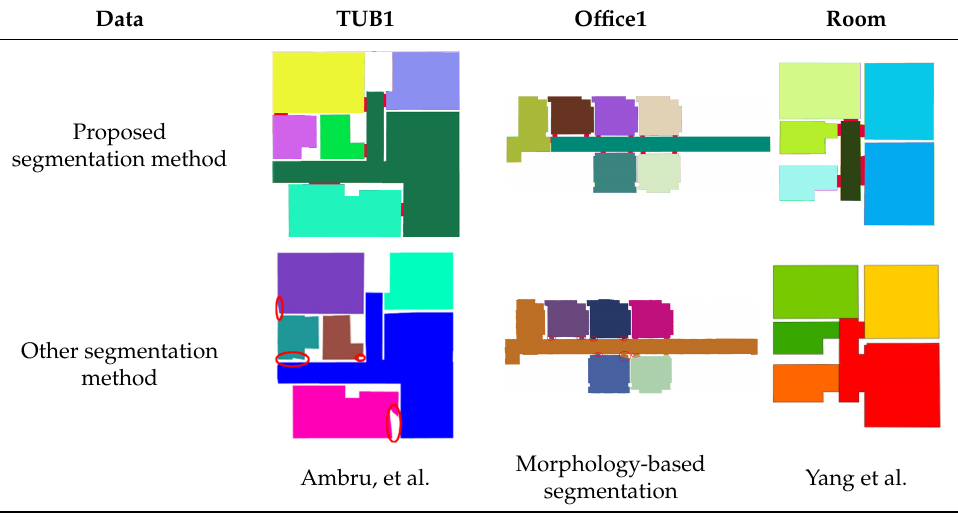
Table 3. Result comparison of room segmentation methods.